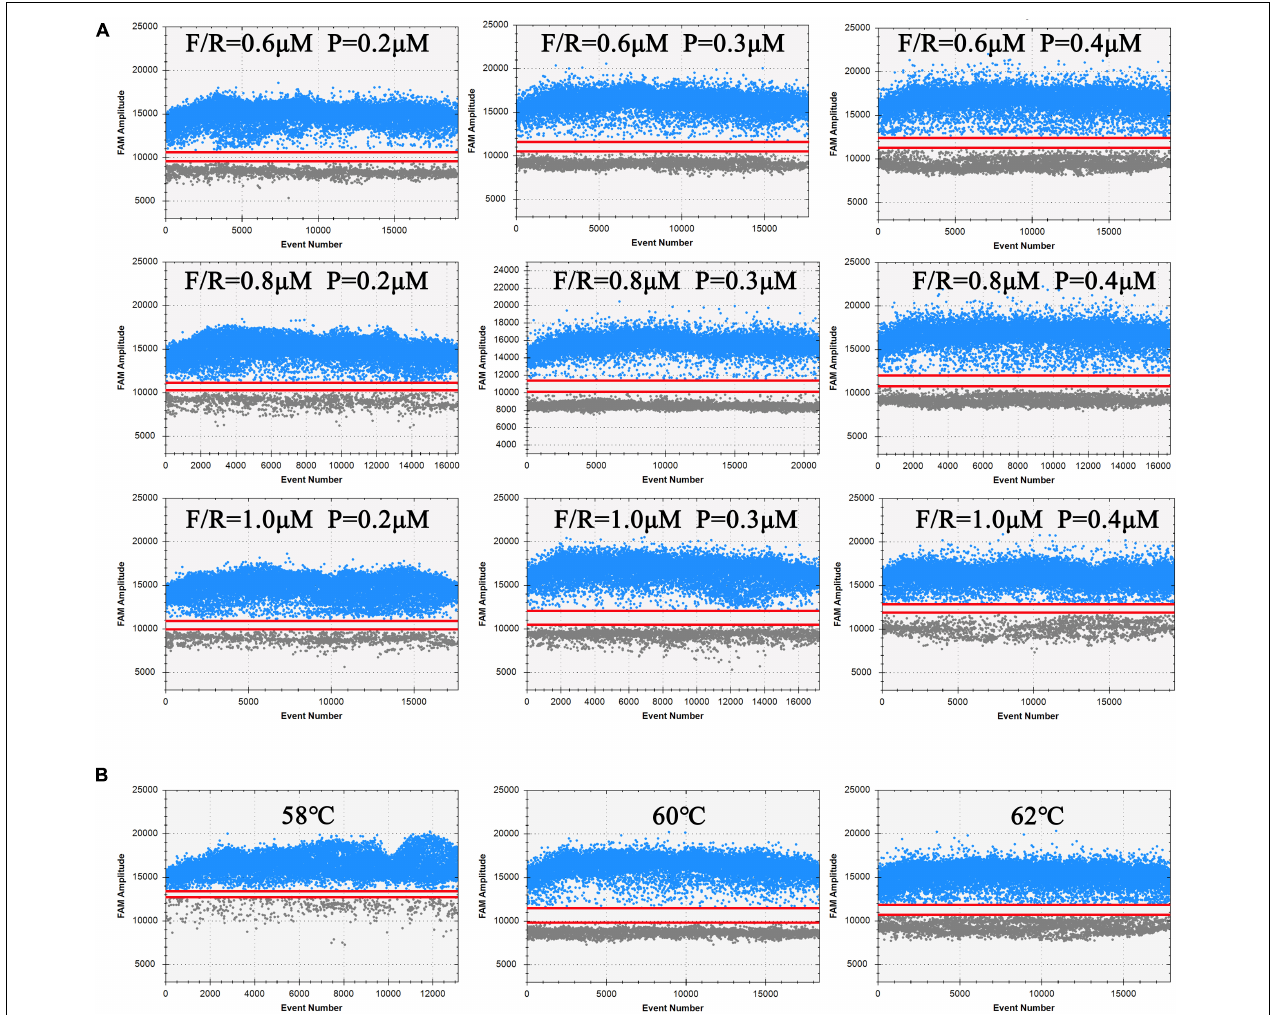
FIGURE 2 | Analysis results of ddPCR under different processing conditions. Blue dots represent positive droplets, and gray dots represent negative droplets. The figures show the most available results of three independent replicates. (A) Optimization of primers and probe concentration combinations on ddPCR. (B) Optimization of annealing temperature on